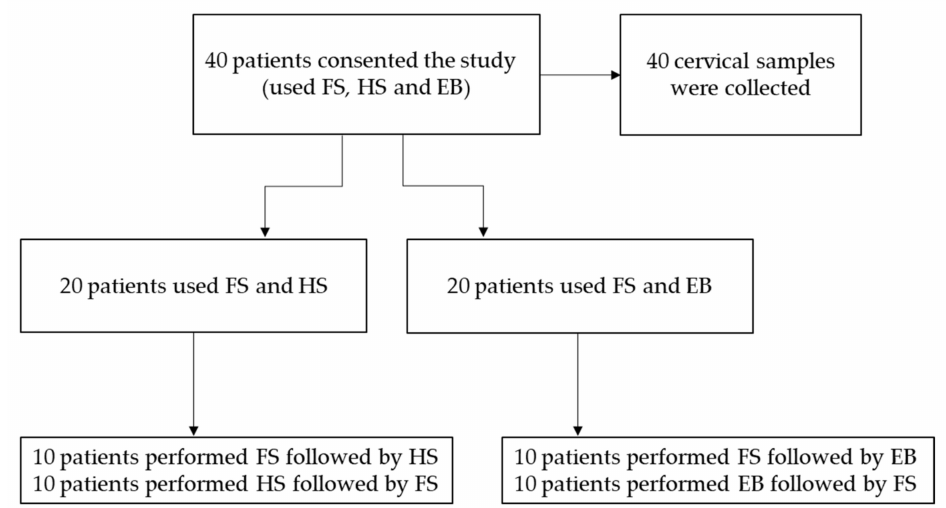
Figure 1. Summary of the work (flow